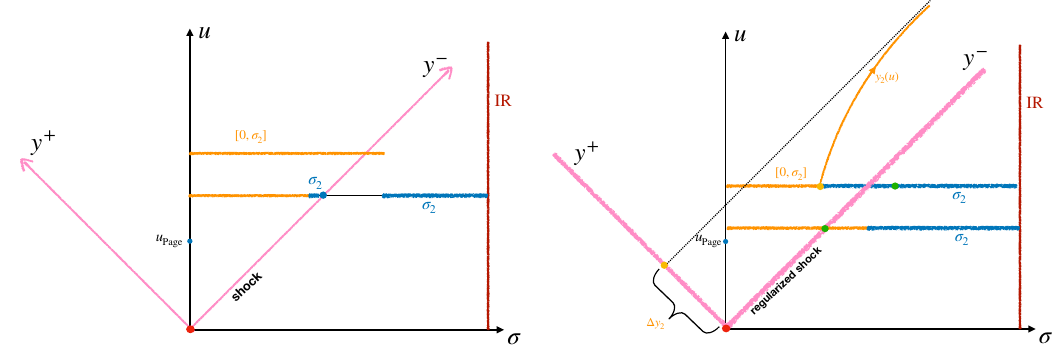
Figure 12 . The yellow lines show the finite bath interval with T b ≤ T p at a fixed time slice u which has the ability to reconstruct the black hole interior with only including QM but not the L purifier. The blue shadow region presents the expected region where we can put the endpoint of the finite bath interval, i.e. y 2 , and make the subsystem recover the information of black hole. Left: the simple shock wave as a line. Right: the regularized shock wave as a small region indicated by the pink shadow. The yellow curve presents the endpoint y + of the minimal bath interval approaches 2 a constant ∆ y 2 derived in (4.102) with the evolution of